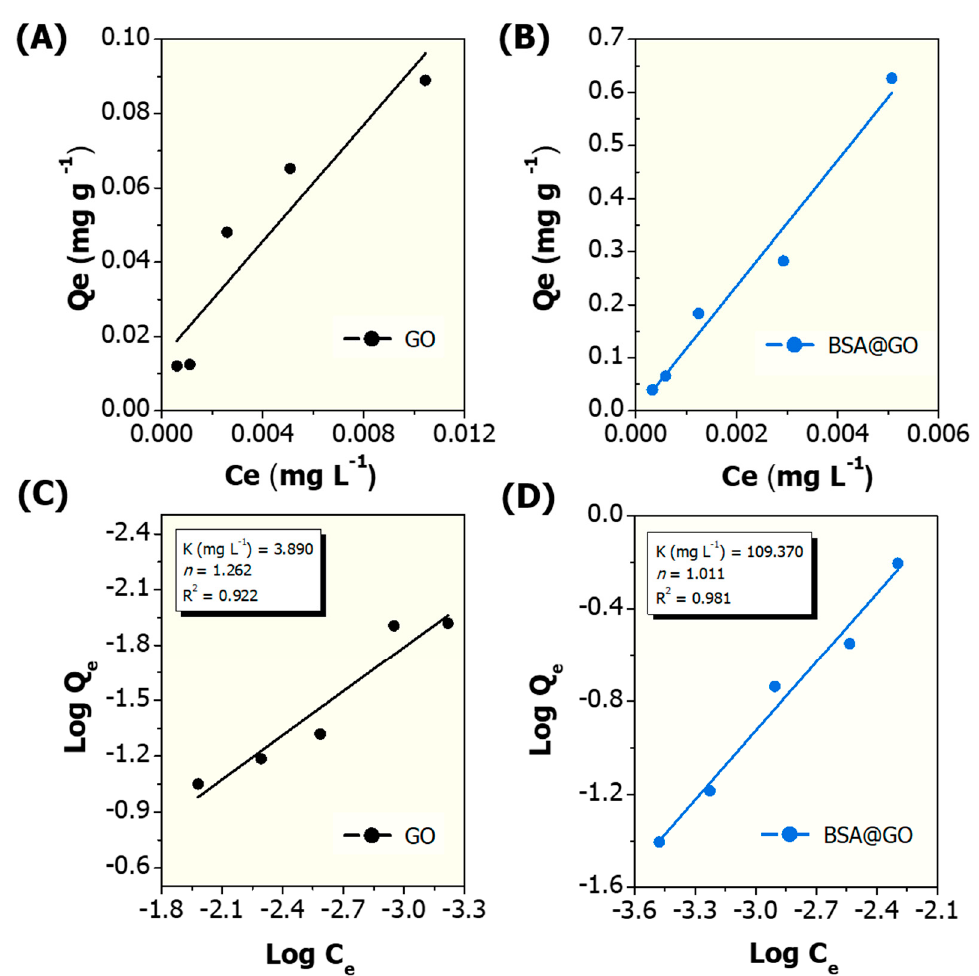
Figure 4. Adsorption capacity of Cd 2 + onto the graphene-based materials in reconstituted water at 20 ◦ C. Adsorption isotherms: ( A ) GO and ( B ) BSA@GO materials; Freundlich isotherms: ( C ) GO and ( D ) BSA@GO materials.